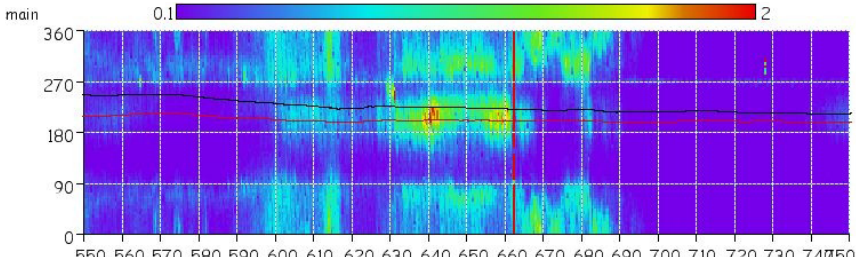
Fig. 6. Pitch angle spectrogram [deg] of 6eV ions (main) as a function of time [s] from T+550s to T+750s. Overlaid with model calculation of expected peak pitch angle [deg] for upflow = 0m/s (black) and upflow = 2km/s (red). (Color bar proportional to differential energy flux eV/cm 2 /s/sr/eV, arbitrary